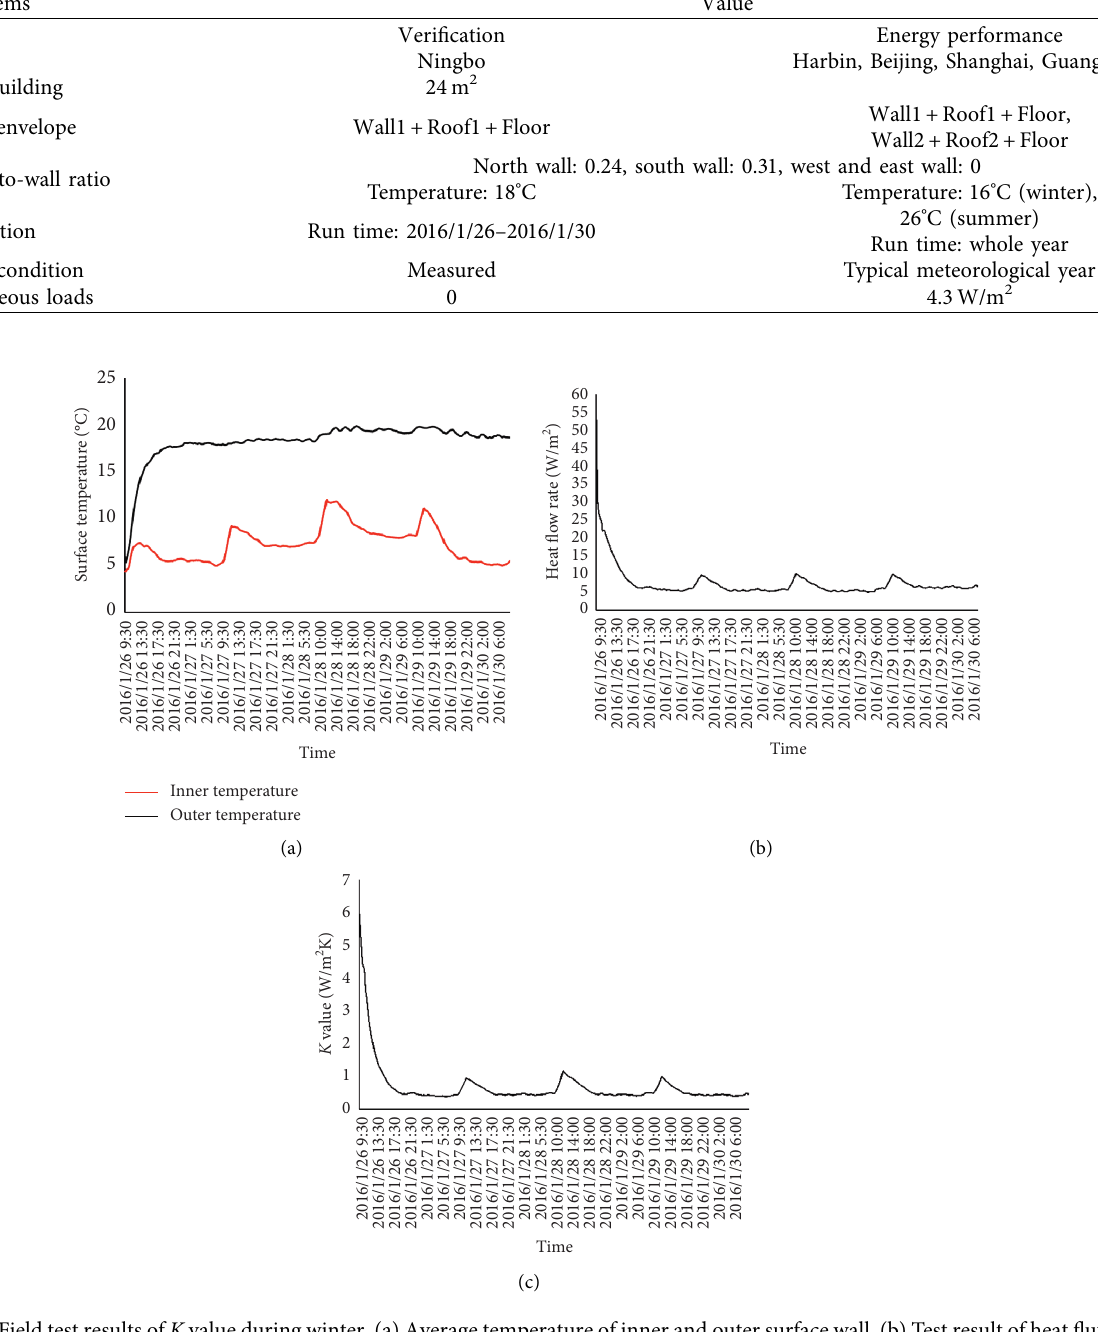
Figure 9: Field test results of K value during winter. (a) Average temperature of inner and outer surface wall. (b) Test result of heat flux rate. (c) Calculated K value during the